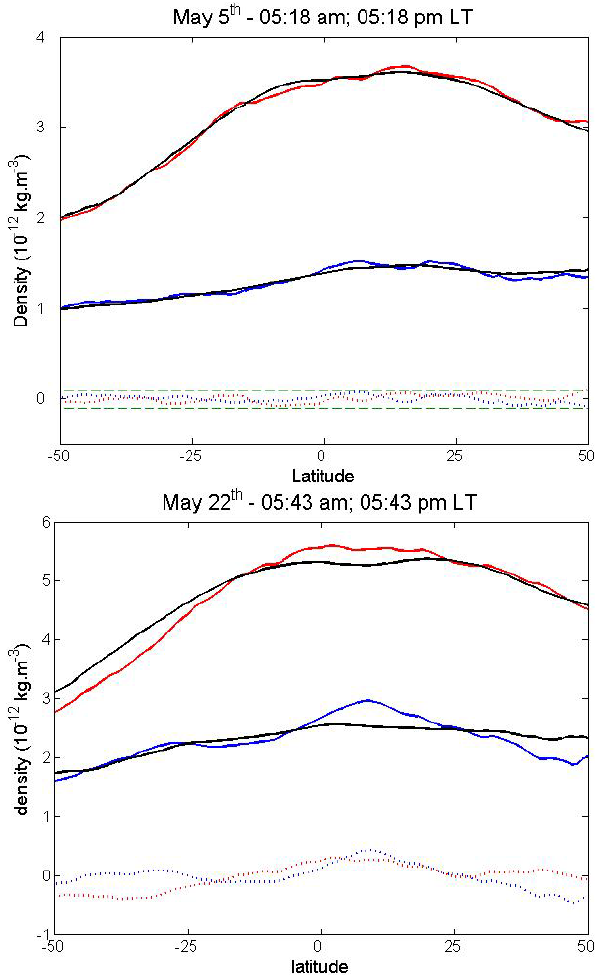
Fig. 2. Example of results of the 15-orbit SVD analysis. The observed density variations along the NS and SN orbit segments ( d (ϕ) ; red line for day time. blue line for night time) are plotted together with their projection along the direction of the first singu- lar vector ( δ 1 (ϕ) ; black line). The residual r 1 , i.e. the difference d (ϕ) – δ 1 (ϕ) is also plotted (dotted lines; red for day time, blue for night time). See Eq. (A1) and text for further explanation. Upper panel: case of one orbit during magnetically quiet periods (5 May, am=9nT); Lower panel: case of one orbit during magnetic activity (22 May, am=46nT). Note the change in the vertical scale between upper and lower pan- els: the dashed green lines correspond to densities equal to +0.1 and − 0.1 10 − 12 kgm − 3 . In both cases, δ 1 ( ϕ) accounts for long space wavelength features in the observed density variations d (ϕ) . The residual is negligible during magnetically quiet periods, while its amplitude may become significant in presence of magnetic activity.